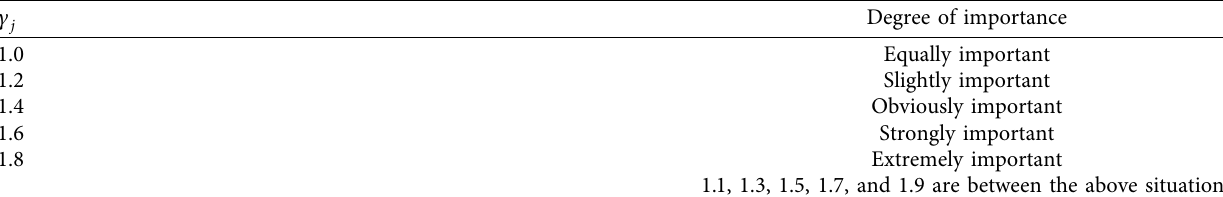
Table 1: c j value reference